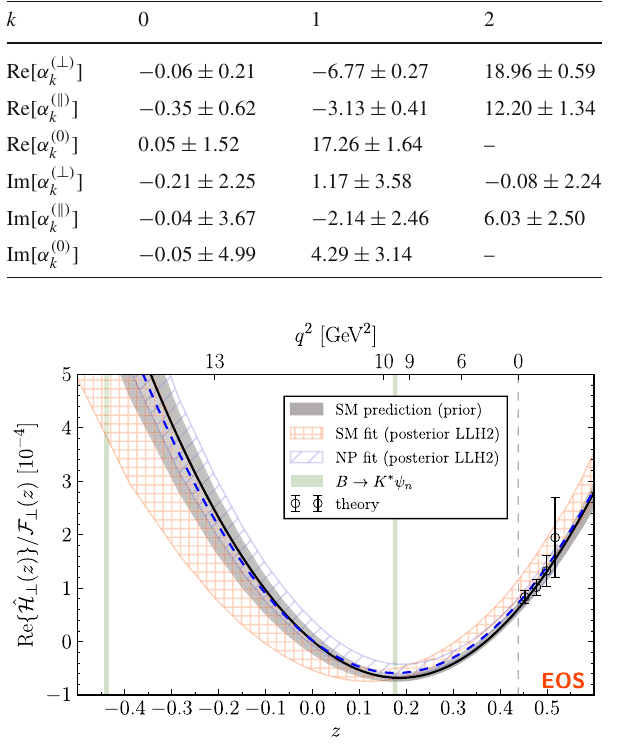
Fig. 1 Results of the prior and posterior fits for the ratio Re [ ˆ H ⊥ ( z ) ] / F ⊥ ( z ) . See the text for details